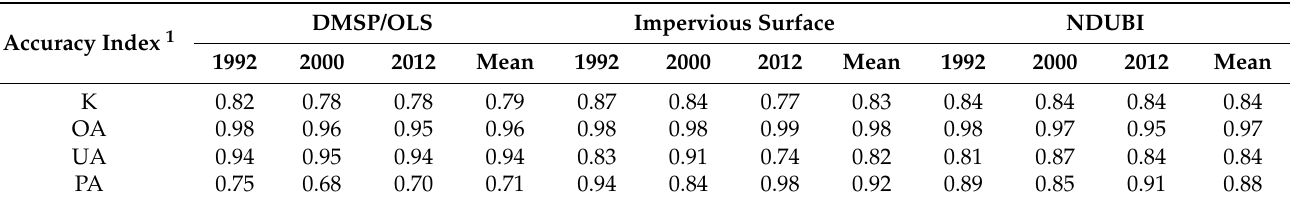
Table 3. The accuracy evaluation results of built-up area extraction method.